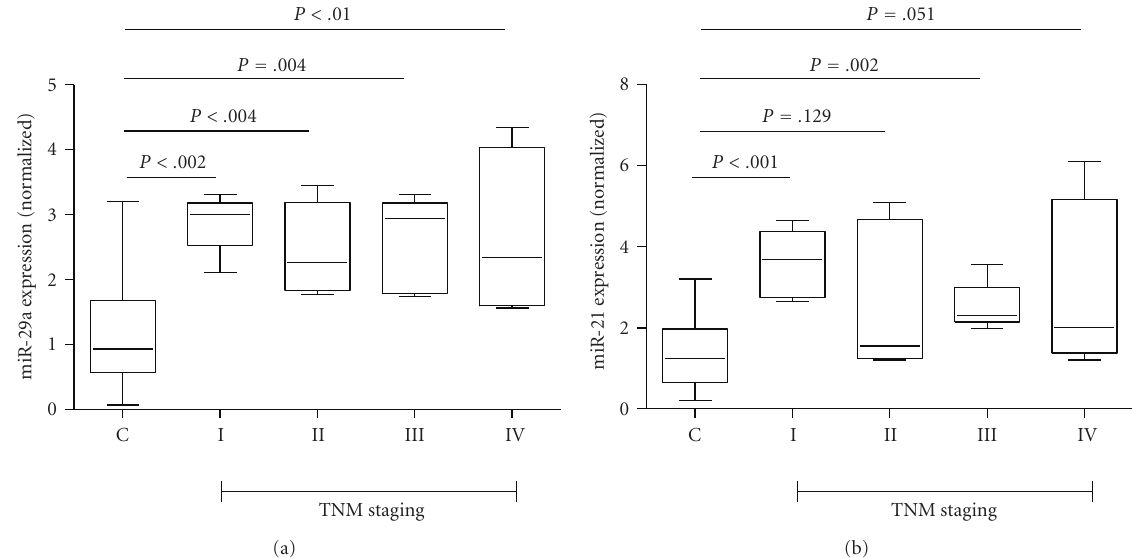
Figure 4: Box plot of serum (a) miR-29a and (b) miR-21 level across stage. Expression levels of the miRNAs were normalized to RUN6B. The box represents the interquartile range, and the line across the box indicated the median value. Statistically significant di ff erences were determined by Mann-Whitney